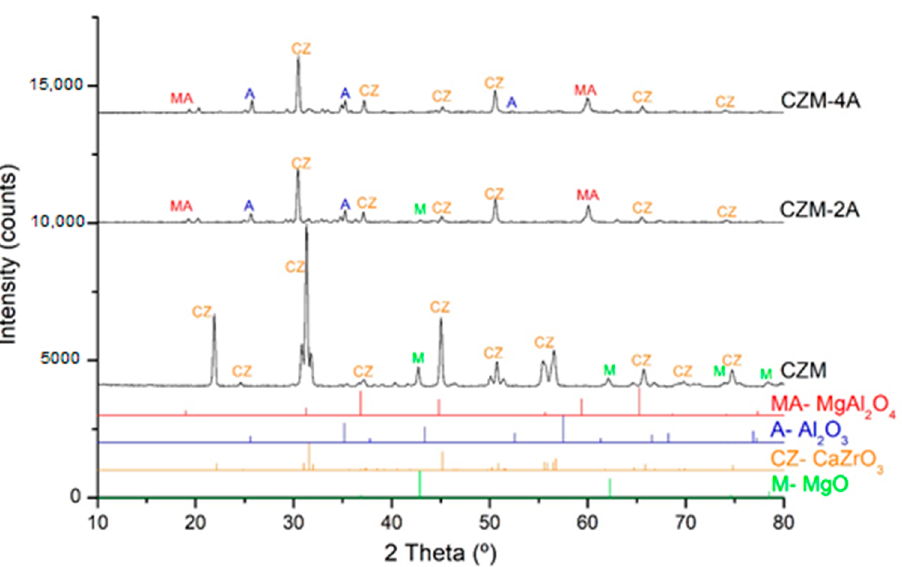
Figure 3. XRD analysis of the three composites: CZM, CZM-2A, and CZM-4A. Theoretical diffractograms of pure phases of CaZrO 3 (XRD file/card #035-0790), MgO (XRD file/card #071-1176), Al 2 O 3 (XRD file/card #46-1212), and MgAl 2 O 4 (XRD file/card #77-1193) were represented. The main peaks identified were: CZ (CaZrO 3 ), M (MgO), A (Al 2 O 3 ), and MA (MgAl 2 O 4 ).